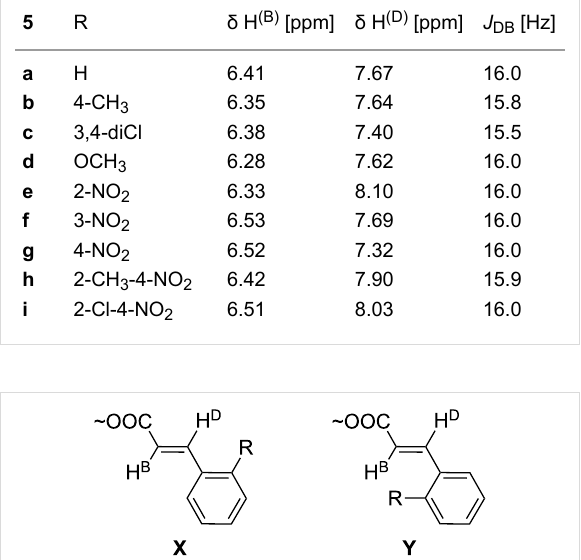
Table 2: Chemical shifts and coupling constants of the hydrogen atoms belonging to the double bond of 5a – i :